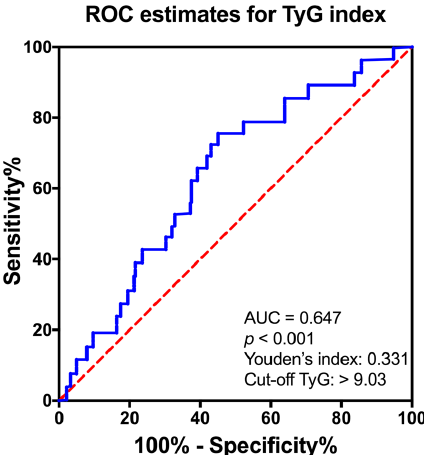
Figure 4. The optimal cutoff points of the TyG index for VDD diagnosis. Data were analyzed by ROC analysis. AUC values and Youden’s index are showed in brackets. Dotted line showed a random distribution.